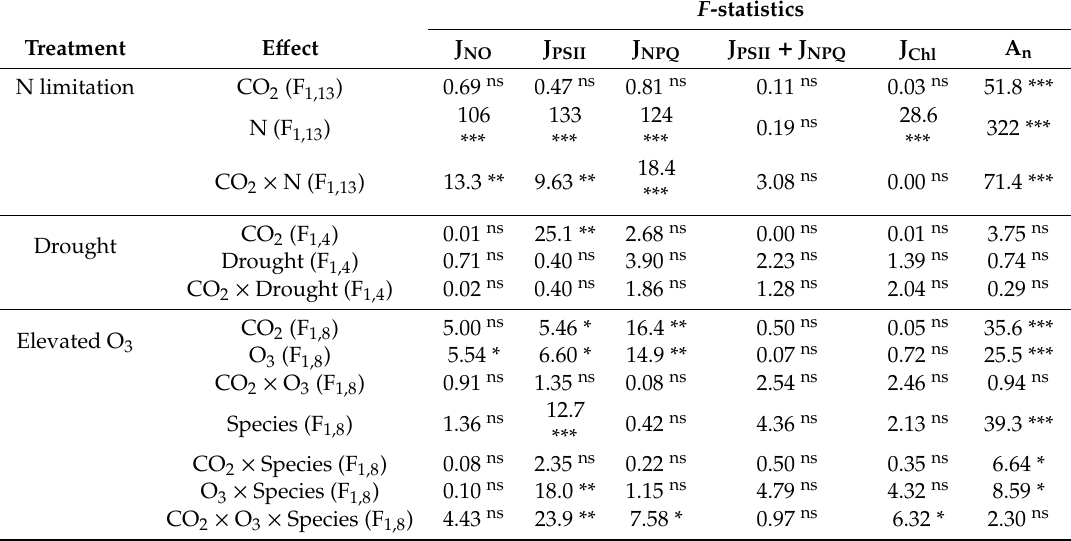
Table 1. F values of Analysis of Variance (ANOVA) to test the effects of various environmental stresses (N limitation, drought and elevated O 3 ) under ambient or elevated CO 2 on J NO , J PSII , J NPQ , J PSII + J NPQ , J Chl , and A n measured at respective growth CO 2 concentrations. Significant effects are indicated in the table by